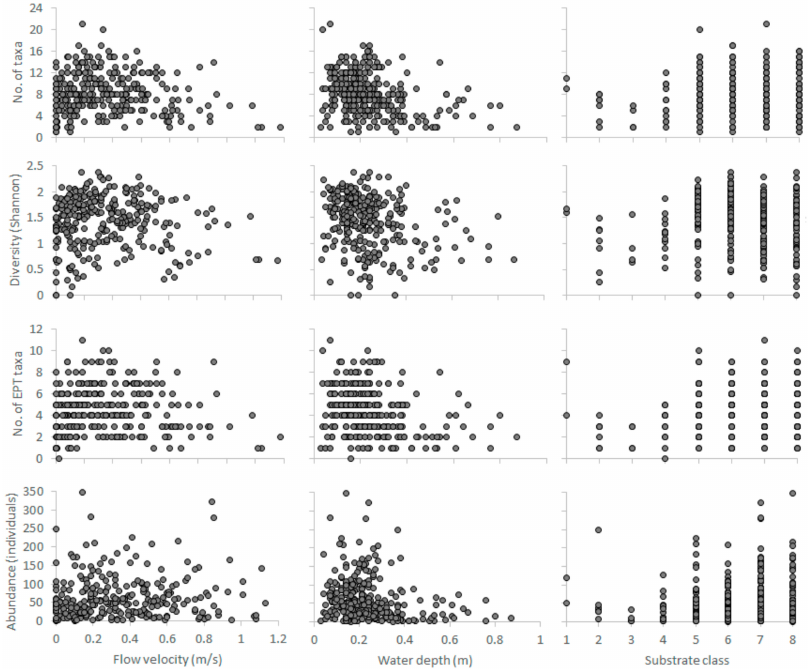
Figure A4. Hydroecological relationships developed from the RM4-type samples ( n = 280) of the benthos-GR dataset between the three abiotic predictors and the four selected biotic response variables-metrics. Substrate classes; 1: Silt, 2: Sand, 3: Fine gravel, 4: Medium gravel, 5: Large gravel, 6: Small stones, 7: Large stones, 8: Boulders. EPT: Ephemeroptera, Plecoptera,